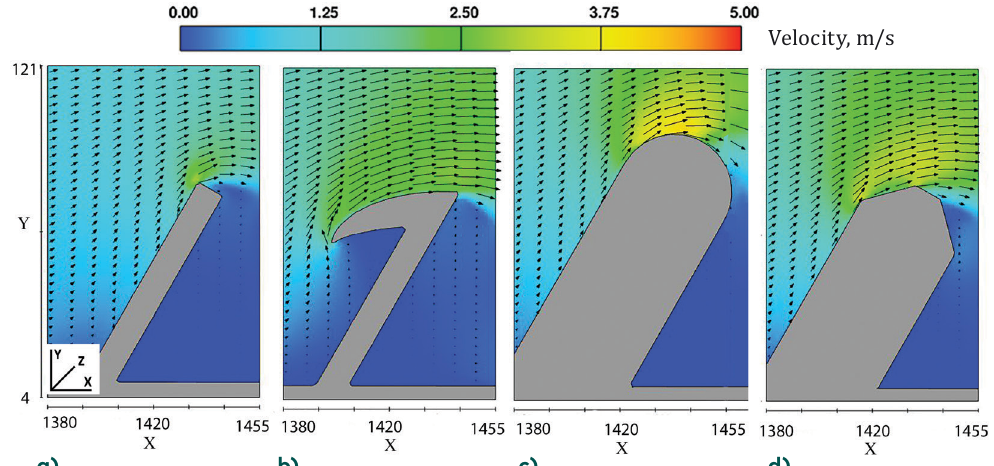
Figure 13. Velocity distribution at the height of 1 m from the floodplain bed for flow-guiding embankment at a 30° skew angle: a) vertical-wall; b) elliptical guide bank; c) spill-through; d)